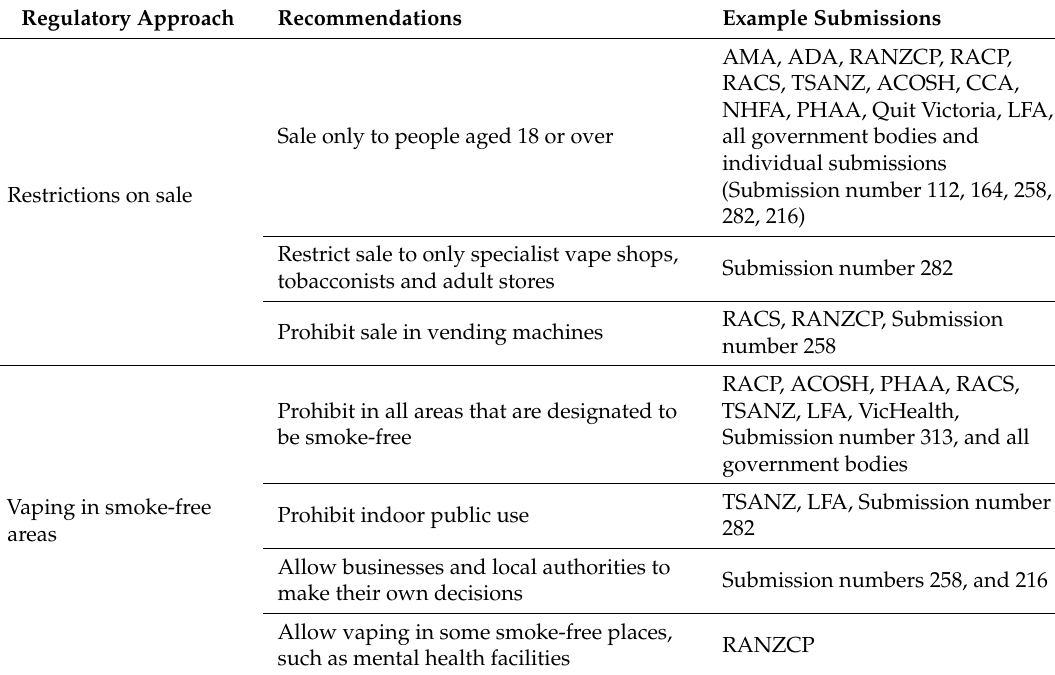
Table 4. Proposed specific regulatory approaches to reduce the risk and maximize benefits of